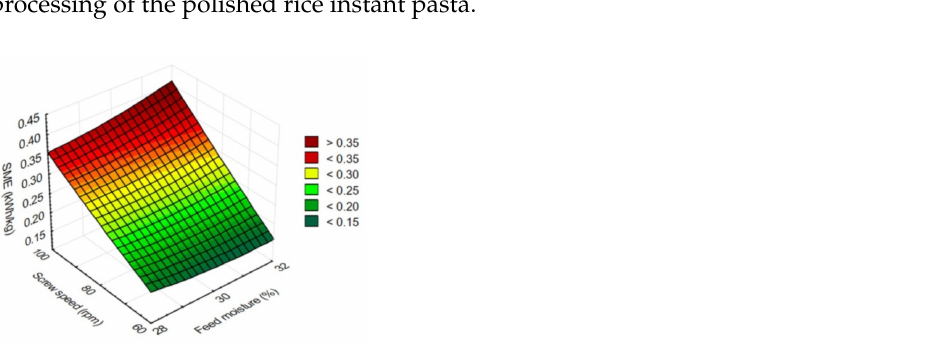
Figure 3. Specific mechanical energy (SME) as affected by feed moisture and screw speed during the processing of rice